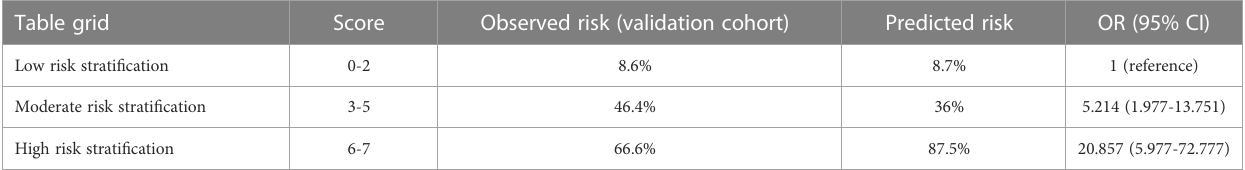
TABLE 6 Risk of neurological deterioration for low, moderate, and high-risk individuals according to the score model. Table grid